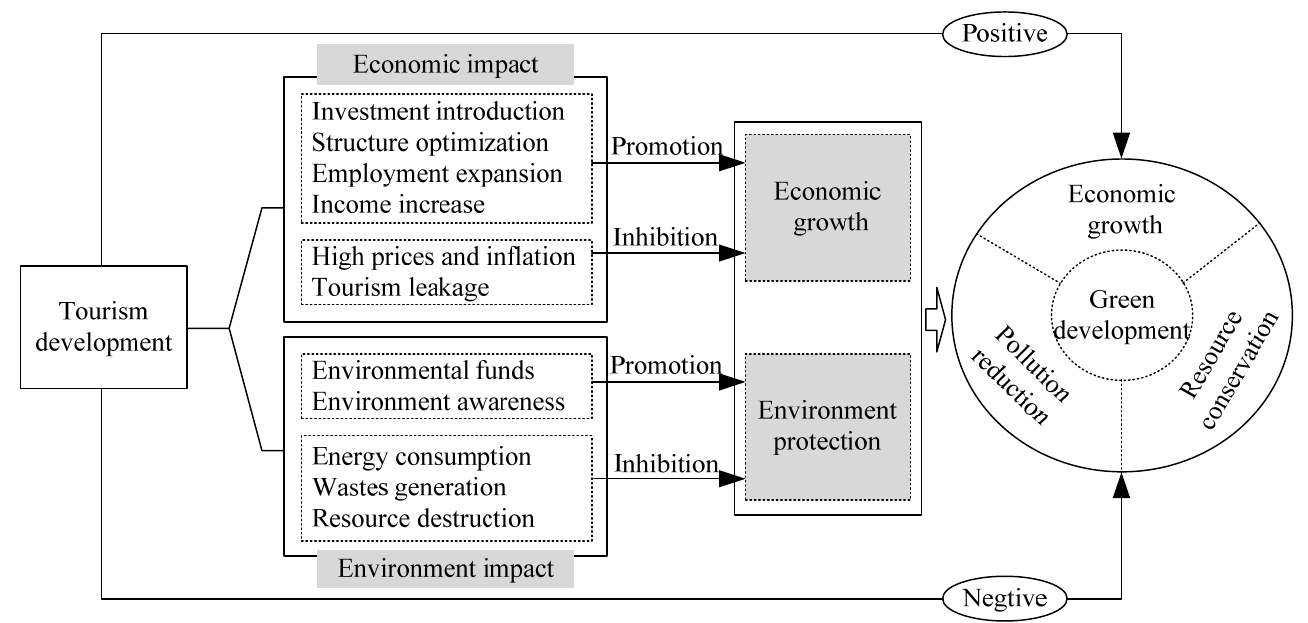
Figure 1. Mechanism of tourism affecting green development.